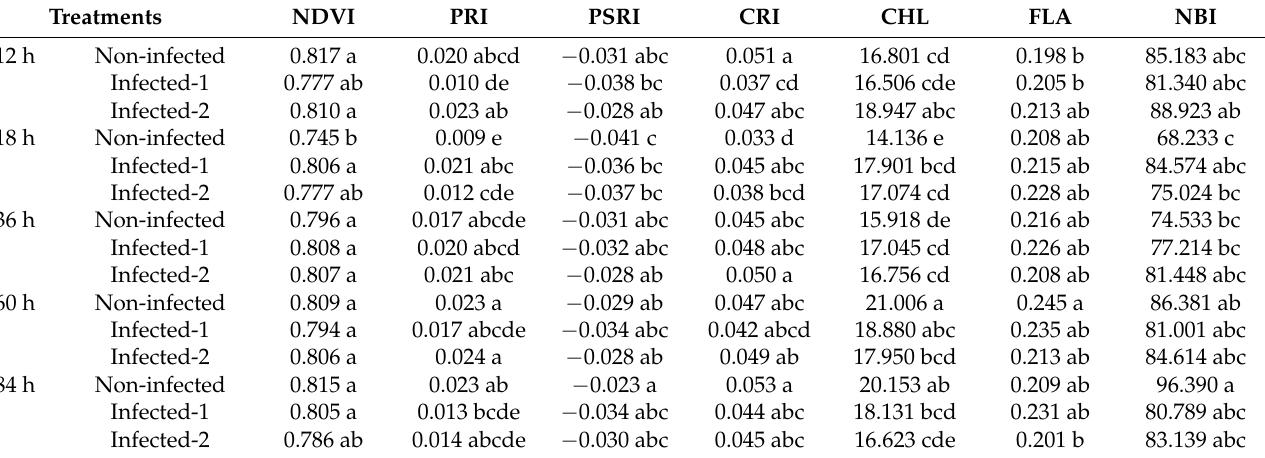
Table 2. Non-destructive measurements of leaf spectral reflectance indexes in “Little Gem” lettuce after 12, 18, 36, 60, and 84 h of artificial